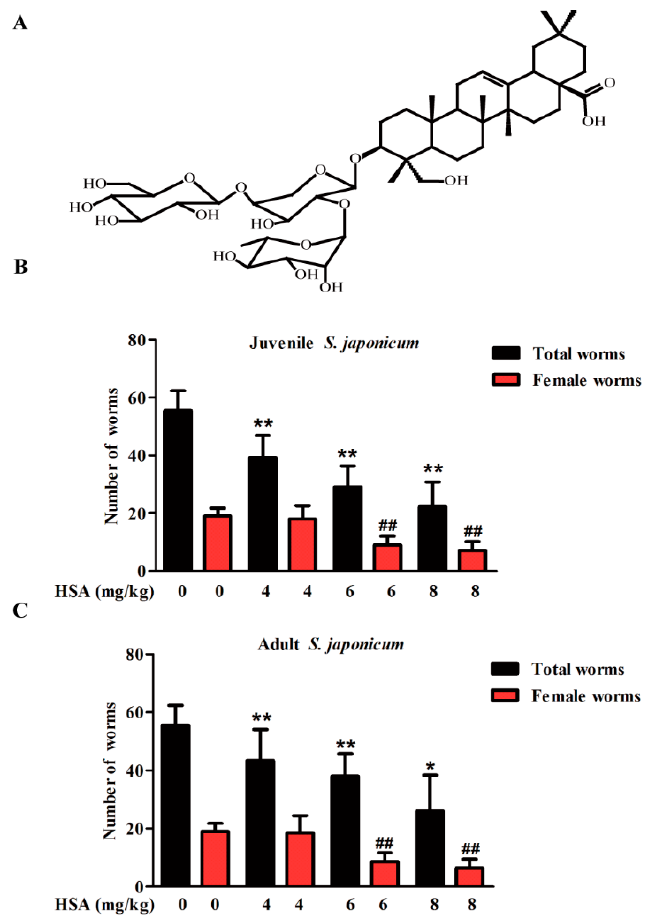
Figure 1. Dose-response relationship of HSA was administered to mice harboring S. japonicum . ( A )